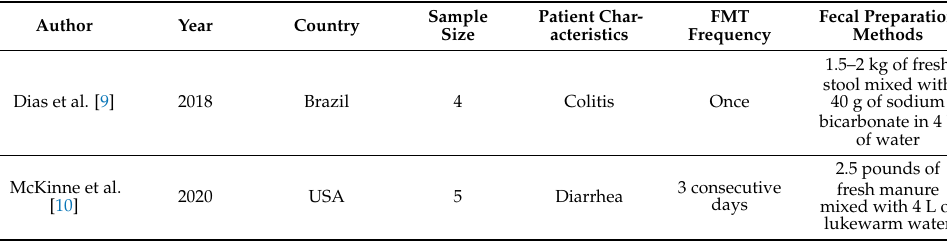
Figure 1. PRISMA flowchart of included studies. Table 1. Characteristics of the included studies.